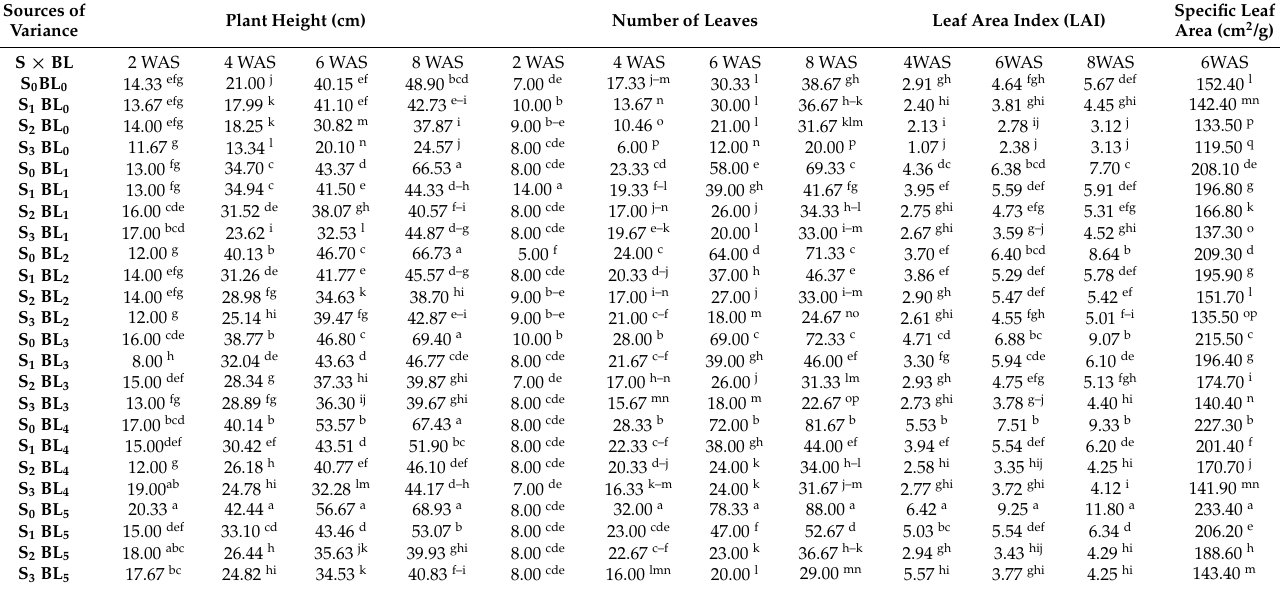
concentration (S 3 ) significantly ( p ≤ 0.05) produced the tallest plants, while at 8 WAS, at the same salt concentration, BL 1 (seedling stage) and BL 4 produced the tallest plants. Table 1. Interaction effects of salinity (S) and brassinolide (BL) on plant height, number of leaves, leaf area index and specific leaf area of soybean at different sampling